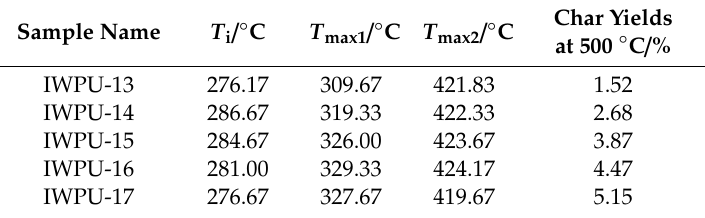
Figure 3. DSC curves of IWPU films. Table 6. T g of IWPU films.